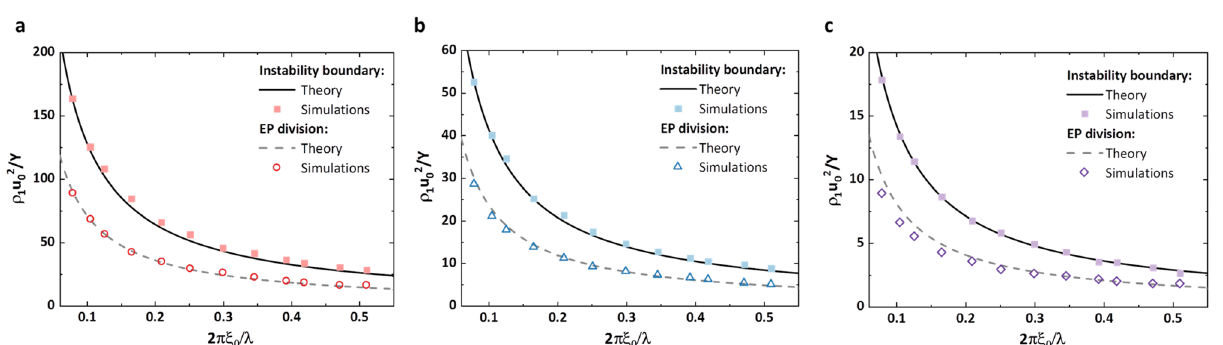
Figure 3. Instability boundary and EP division by simulations and theory. Three combinations of A T and M 0 are calculated i.e. ( a ) A T = 0.7980 and M 0 = 0.4754, ( b ) A T = 0.4958 and M 0 = 0.3803, ( c ) A T = 0.0 and M 0 = 0.2377. ˆ (cid:31) ˆ Y The axis 2 πξ 0 / λ and ρ 1 u 02 / Y in the figures are and . Solid point and hollow point in each figure represents simulation results of instability boundary and EP division respectively. Solid line and dash line means results by theory for instability boundary and EP division. The results with identical A T and M 0 by numerical simulation and analytical theory are plotted in one figure for